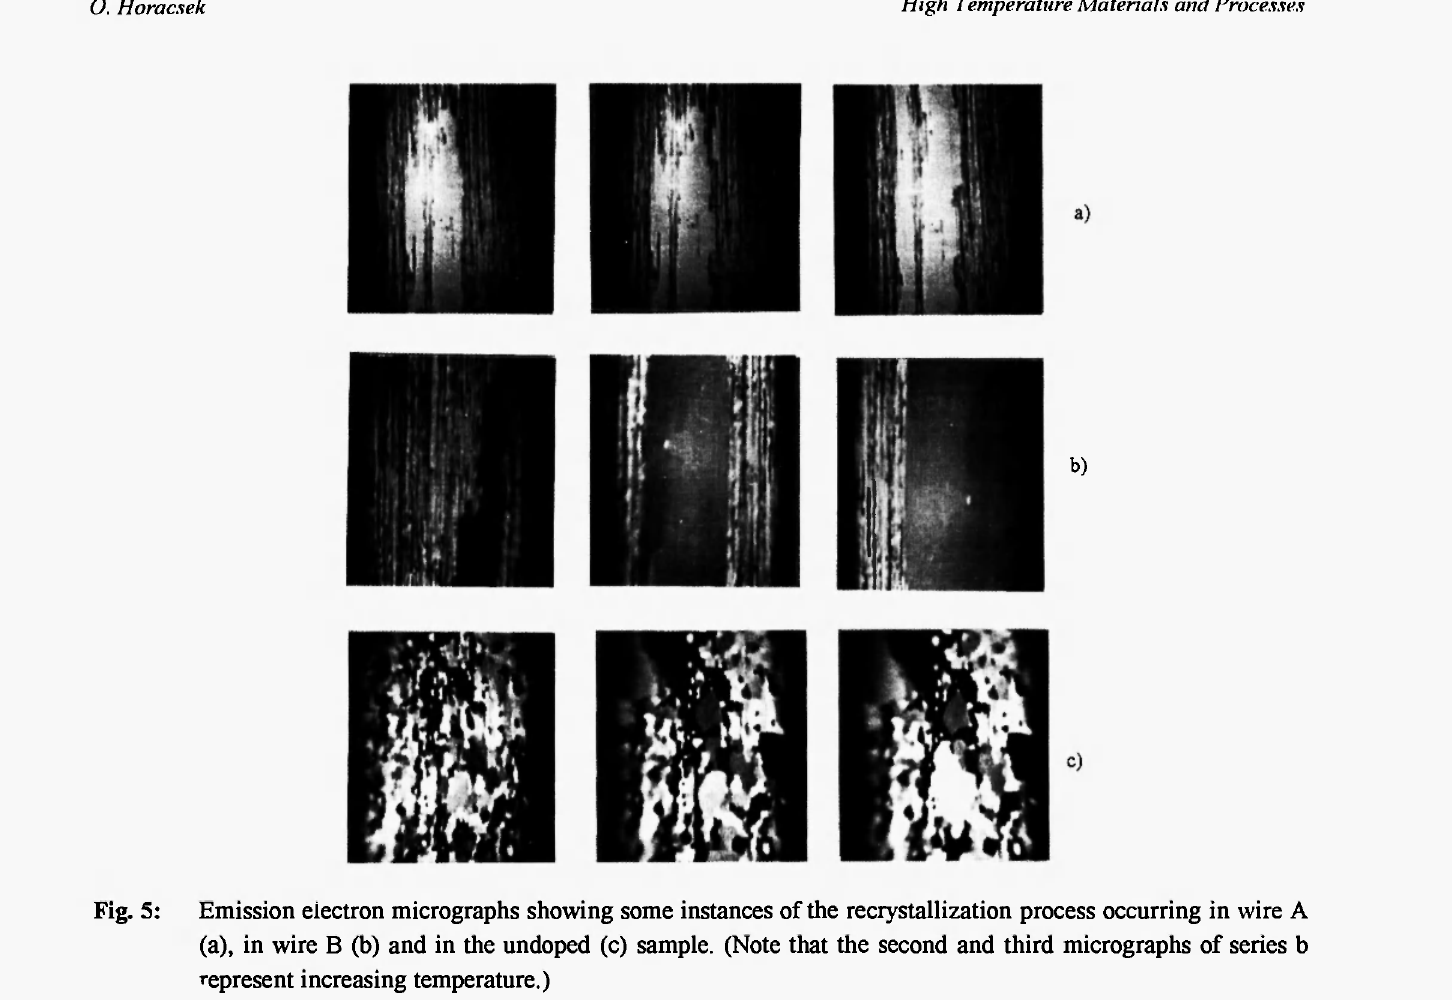
Fig. 5: Emission electron micrographs showing some instances of the recrystallization process occurring in wire A (a), in wire Β (b) and in the undoped (c) sample. (Note that the second and third micrographs of series b represent increasing